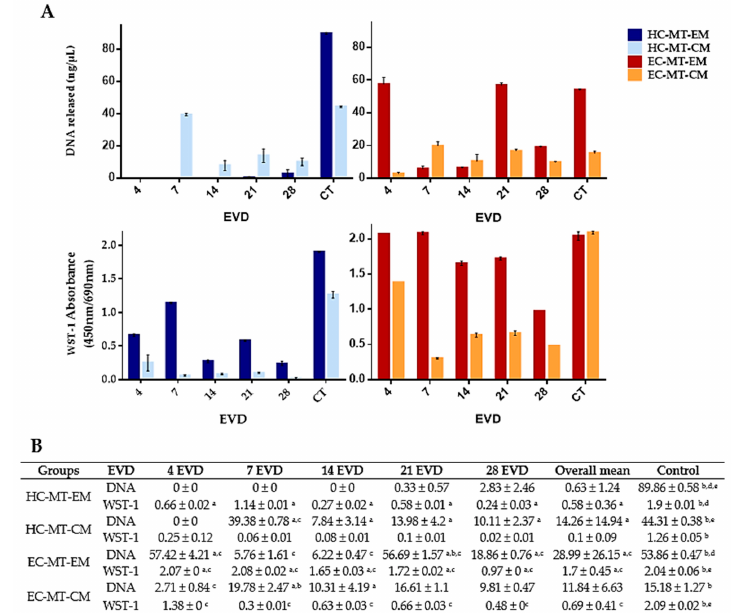
Figure 4. Graphical representation of DNA released (ng/µl) of human chondrogenic MTs for each day of EVD ( A ). Quan- titative results of the DNA released and WST-1 biochemical test values of MT-forming human chondrocytes for each day of EVD ( B ). Results are shown as mean ± SD values for DNA in ng/µl and for WST-1 in absorbance (450nm/690nm) for each experimental group and day of ex vivo development (EVD). In this study, p < 0.05 was considered statistically sig- nificant for the Mann–Whitney nonparametric test. Significant differences between groups are indicated with letters as follows: a Differences between MTs (HC or EC) with EM and their respective cell source MT with CM. b Differences be- tween MTs (HC or EC with EM or CM) and their respective cell source 2D media control. c Differences between HC-MTs with EM or CM and EC-MTs with the same culture media. d Differences between HC- or EC-2D control with EM and their respective cell source 2D control with CM. e Differences between HC-2D control with EM or CM and EC-2D control with the same culture media.